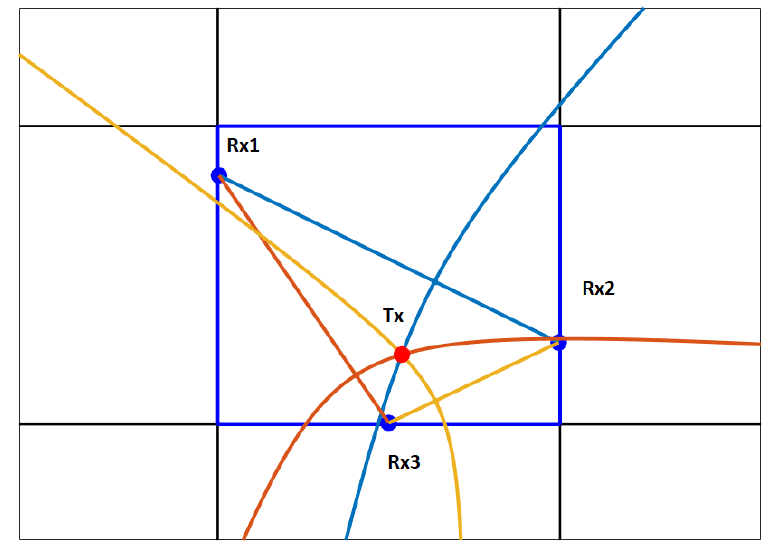
Figure 10. Geometric interpretation of